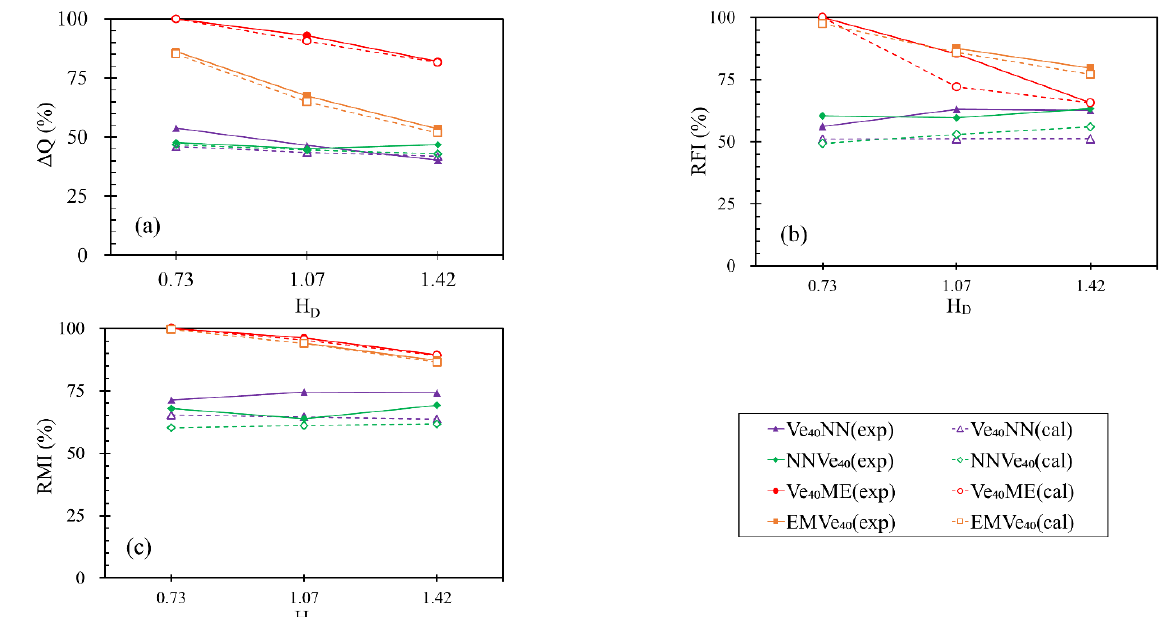
Figure 5. Reproductivity of the indices that compare the effectiveness of hybrid structures. ( a ) Rate of reduction of overflow volume ( ∆ Q), ( b , c ) maximum reduction rates of the fluid force index (RFI) and that of the moment index (RMI).